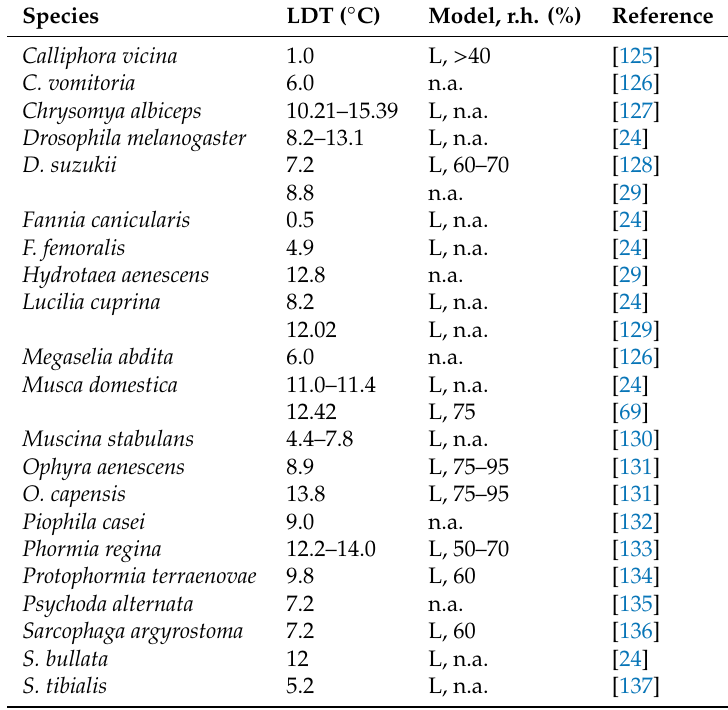
Table 6. Threshold temperatures for the individual development (LDT) of selected stored product flies. L—estimated based on linear model, n.a.—data are not